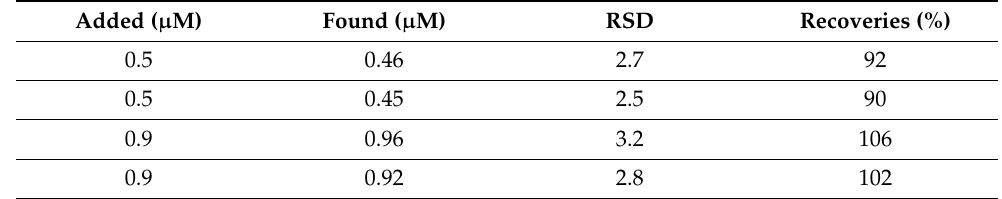
Table 2. Determination for E2 in water samples using a rGO/AuNP/CNT/SPE sensor. Added (µM)